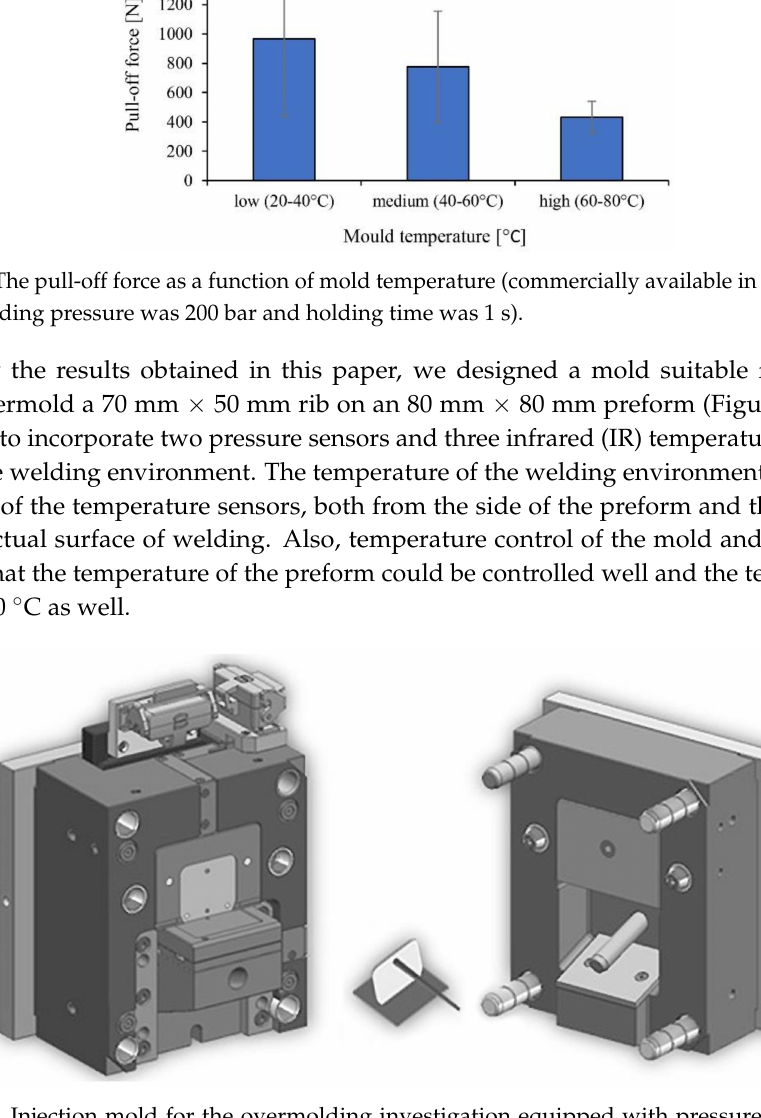
Figure 10. Injection mold for the overmolding investigation equipped with pressure and infrared temperature